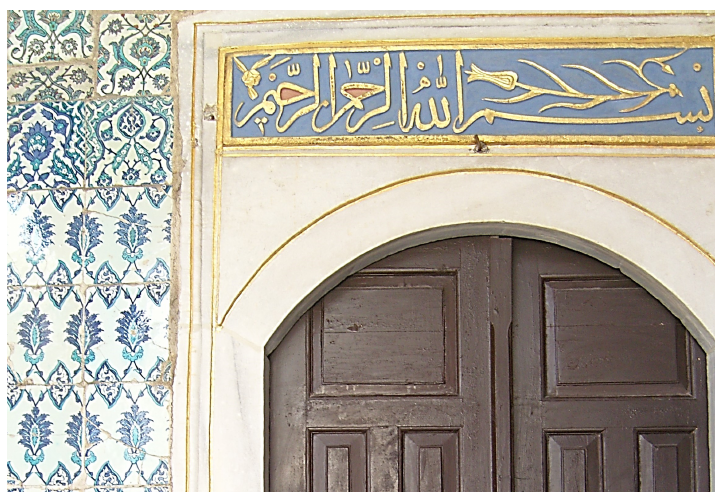
Figure 4. The Topkapı Palace of Istanbul (Zhou Chuanbin, 2013). The calligraphy above the door says “In the name of Allah, the Beneficent, the Merciful” with a tulip in it. Also, in the pattern of wall ceramic tile, we may find many variants of